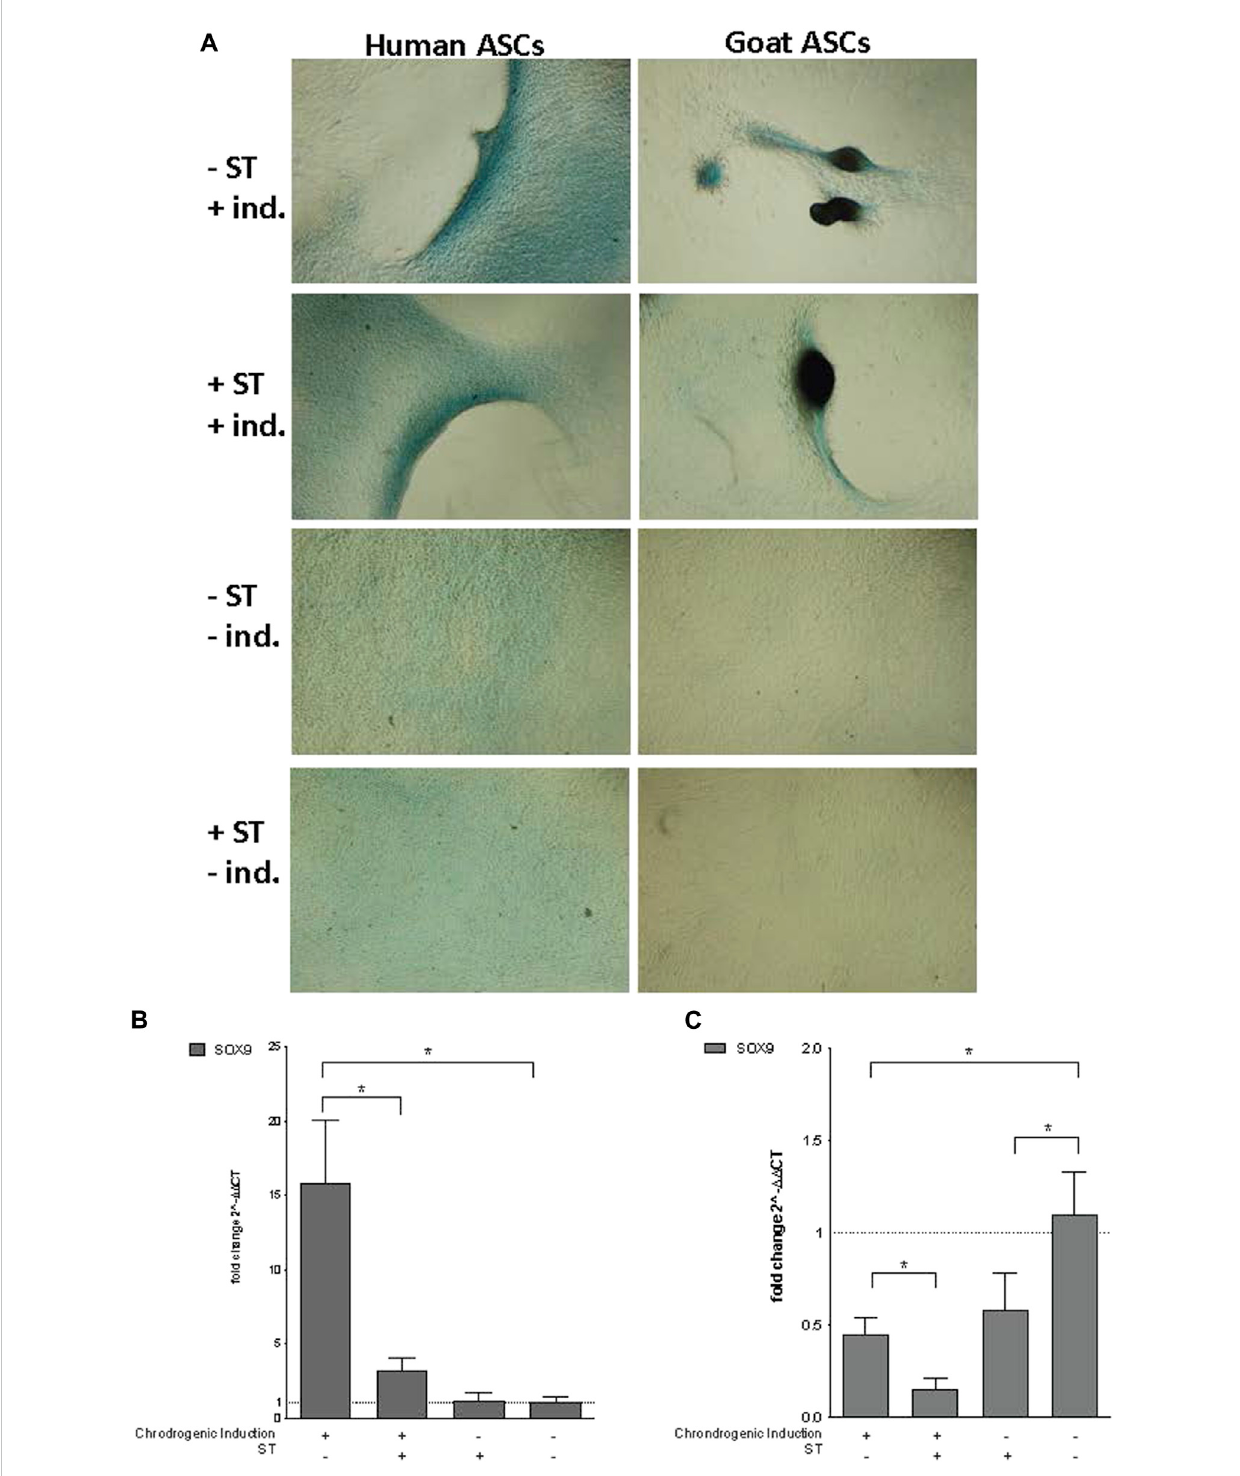
FIGURE 5 Chondrogenic induction. Representative images are shown in phase contrast at ×40 magni fi cation. (A) Alcian Blue staining of chondrogenic differentiation in ASCs post-microbial association. Human and goat ASCs were cultured in chondrogenic differentiation medium for 14 days, and subsequently stained with Alcian Blue. Cellular condensation, as well ridge and micromass formations that stain positive were observed in human and goatASCsinducedforchondrogenesis,independentofS.Ttreatment.SomebackgroundstainingwasobservedinS.T-treatedandnon-treatedcells cultured in control medium, but cells remained in monolayer. Expression of chondrogenic markers post-microbial association was analyzed via quantitativePCRanalysisofSOX9expressionin (B) humanand (C) goatASCsinducedwithchondrogenicdifferentiationmedium and/ortreatedwithS.T.